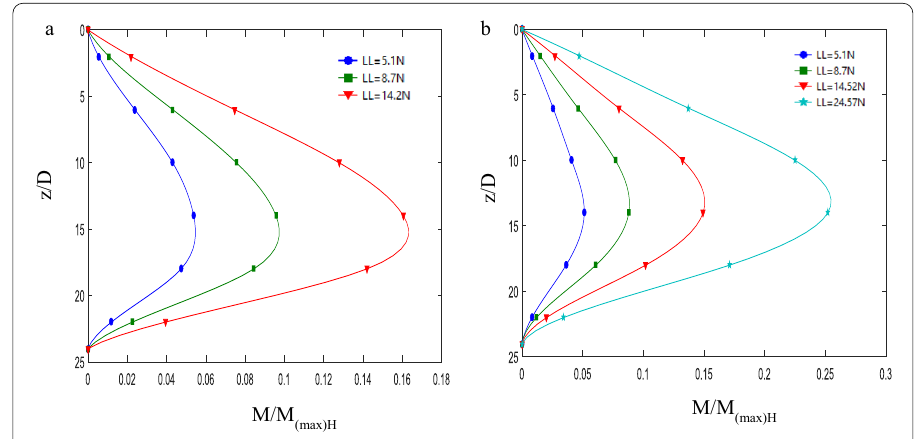
Fig. 19 a Normalized bending moment curve against z/D subjected to pull along the slope 1V: 2H. b Normalized bending moment curve against z/D subjected to pull against the slope 1V: 2H